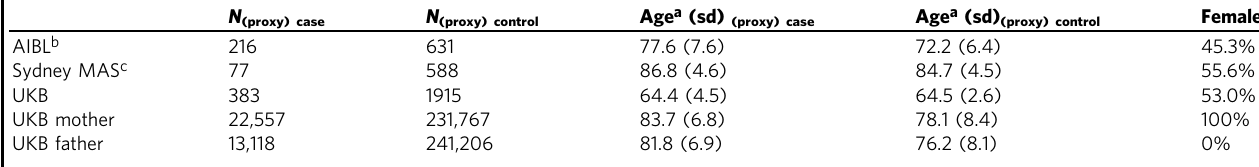
Table 1 Description of late-onset Alzheimer ’ s disease cases and controls from different cohorts.